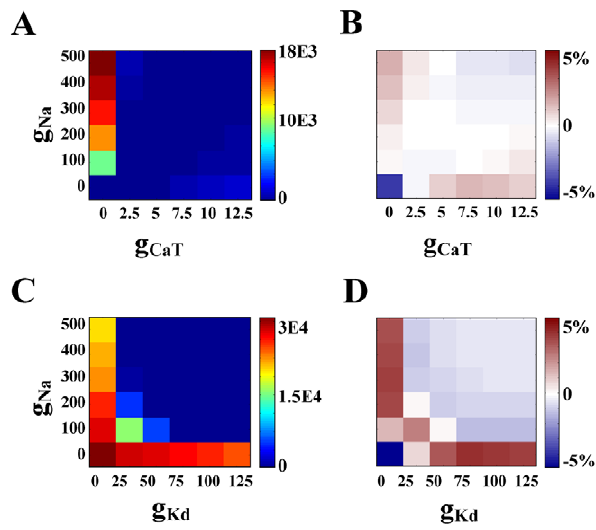
Figure 5. Eleven conductance relationships met the cutoff criteria for correlation, but did not have a convincing linear trend upon visual inspection. These false-positives were not included in the correlation totals. (A) Example of plot which met criteria for correlation, but not linearity. From group ‘‘spikers , 10 Hz’’. (B) Difference plot for relationship in A. (C) Another example. From group ‘‘one-spike bursters’’. (D) Difference plot for relationship in C.